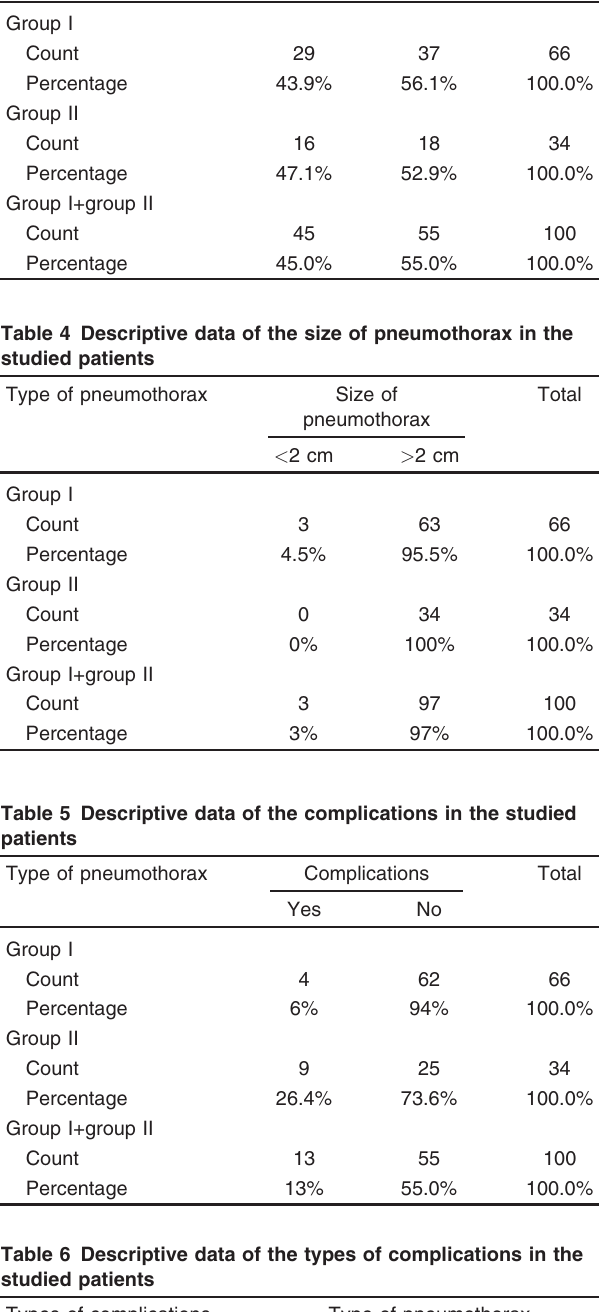
Table 3 Descriptive data of the site of pneumothorax in the studied patients Type of pneumothorax